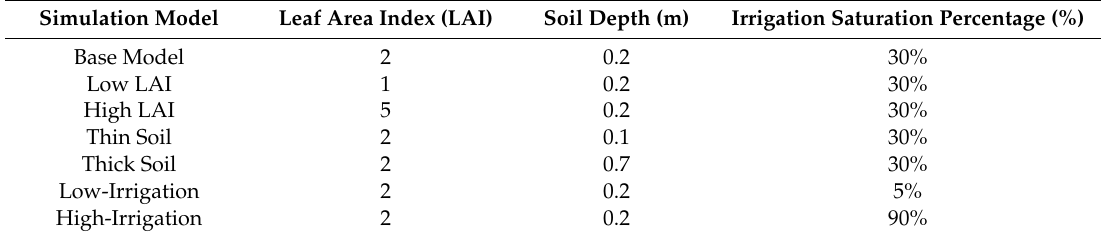
Table 8. Characteristics of di ff erent settings of green roofs simulated under the A1F1 emission scenario.